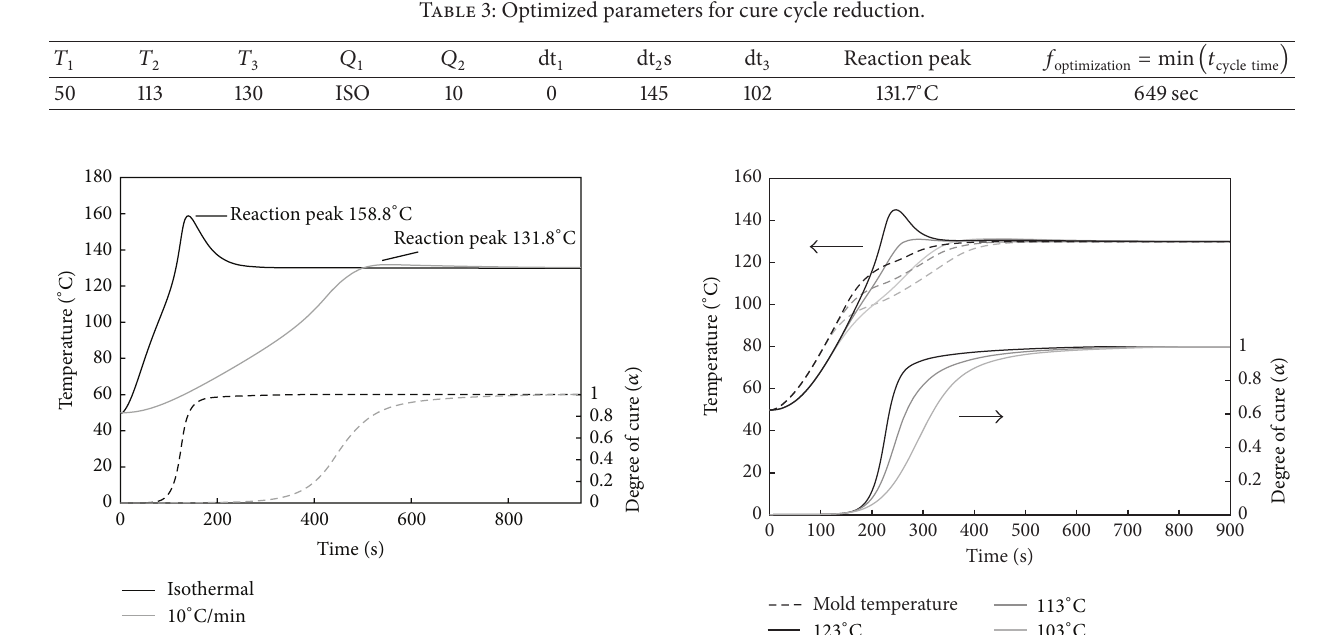
Figure 12: Cure profile of silicone resin increasing dwell tempera- ture ( 𝑇 2 ).